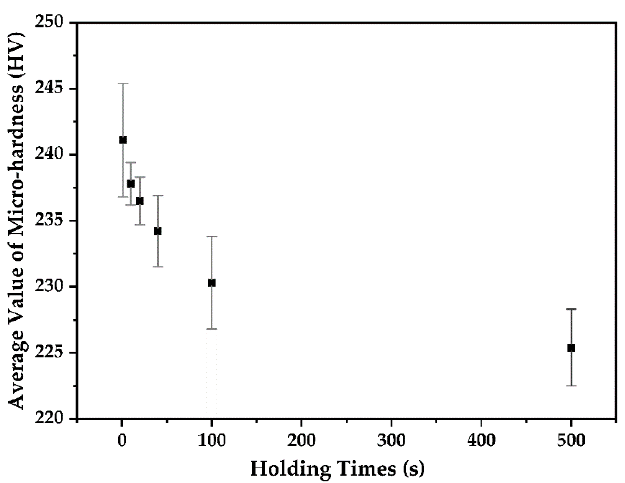
Figure 7. Average micro-hardness values for the samples under different holding times at 1150